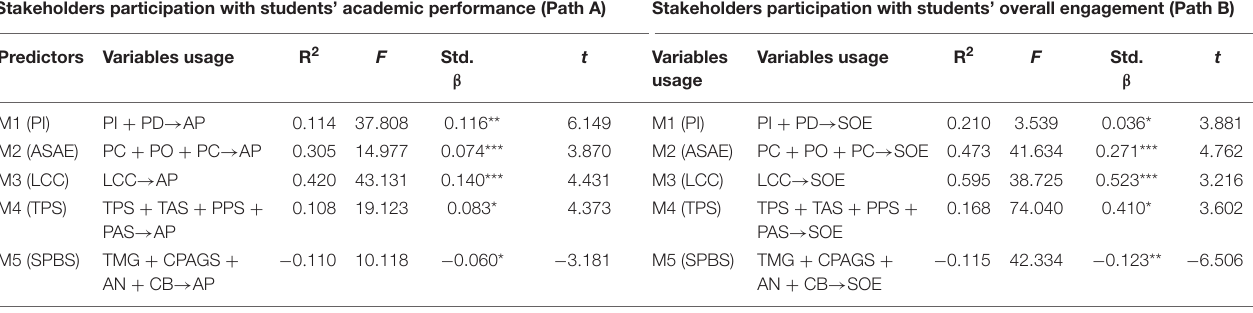
TABLE 5 | Bivariate relationship between stakeholders’ participation (i.e., parents, teachers, peers, and students) along with goal directness and learning climate of the classroom with students’ academic performance through their engagement in learning context ( N = 2,758). Stakeholders participation with students’ academic performance (Path A) Stakeholders participation with students’ overall engagement (Path